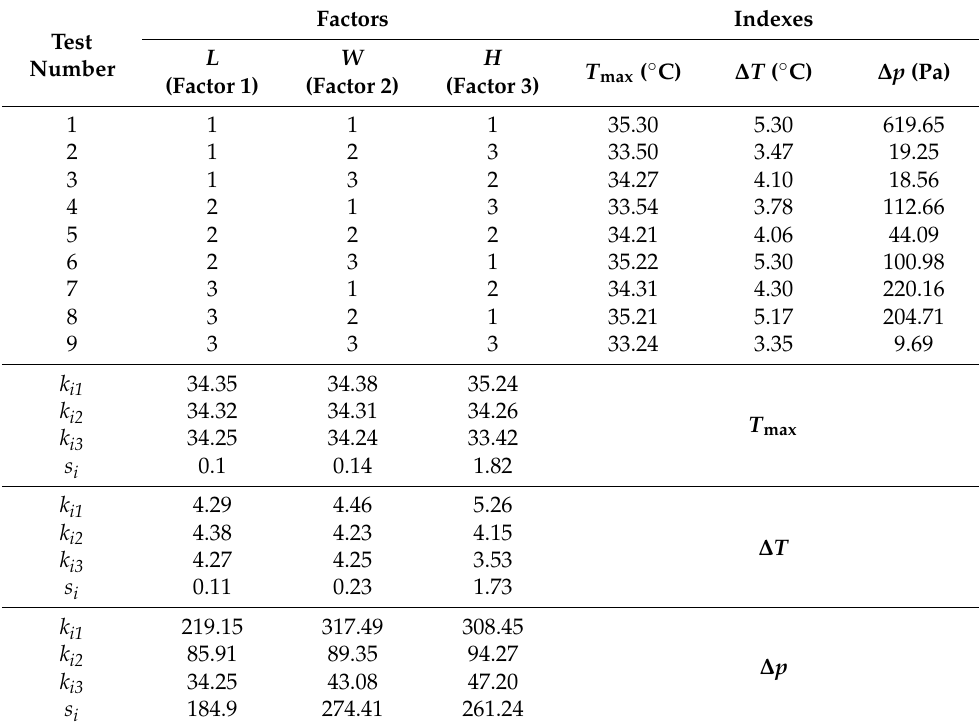
Table 5. Arithmetic means of the indexes and their range value analysis results in the orthogonal